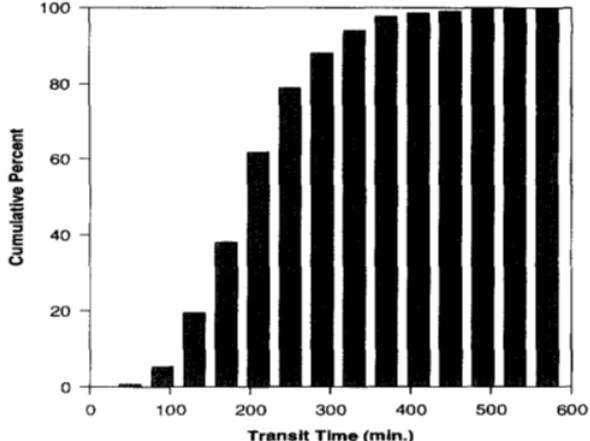
Figure 6. Cumulative percent graph of the small intestinal transit time based on its distribution. Reprinted with permission from Ref. [38]. 1996, Elsevier.